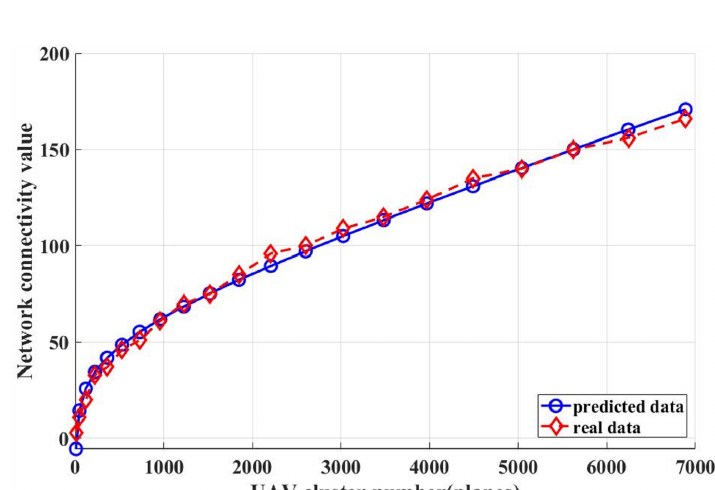
Figure 23. Connectivity regression curve of different-scale UAV